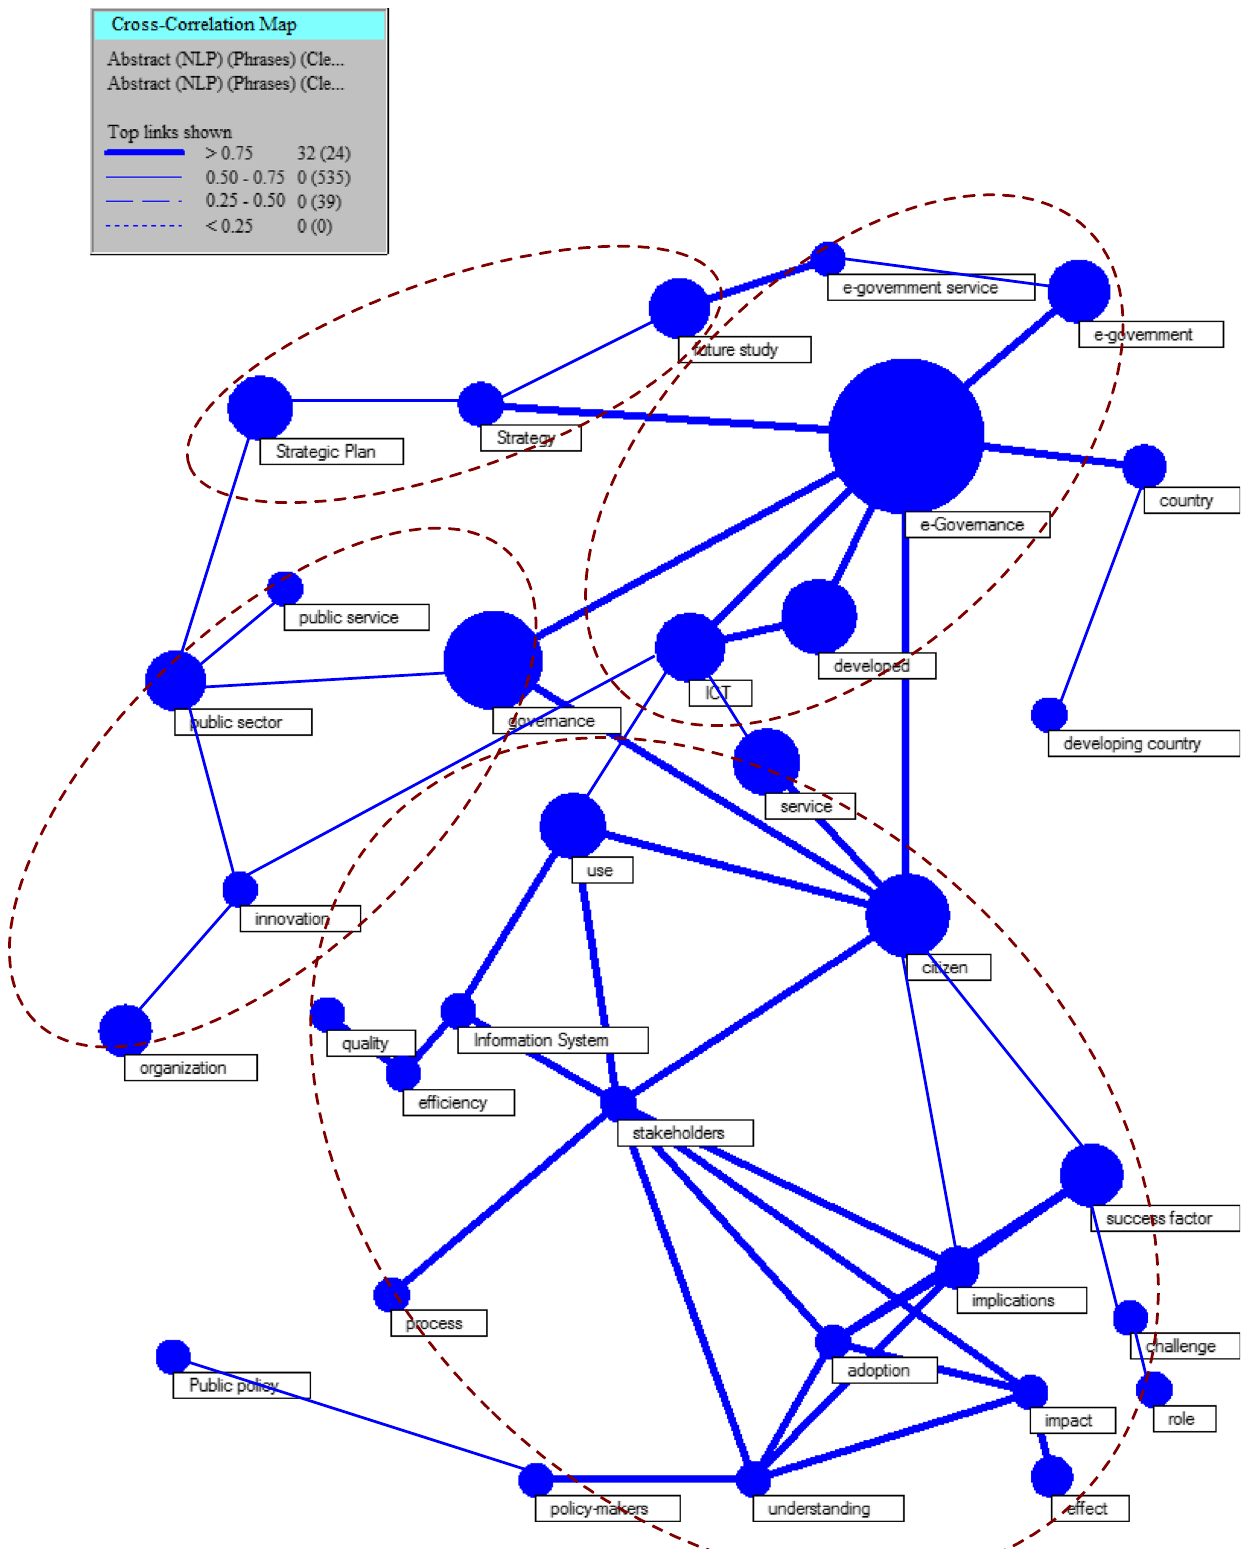
Fig. 10 Keywords network based on use of terms in